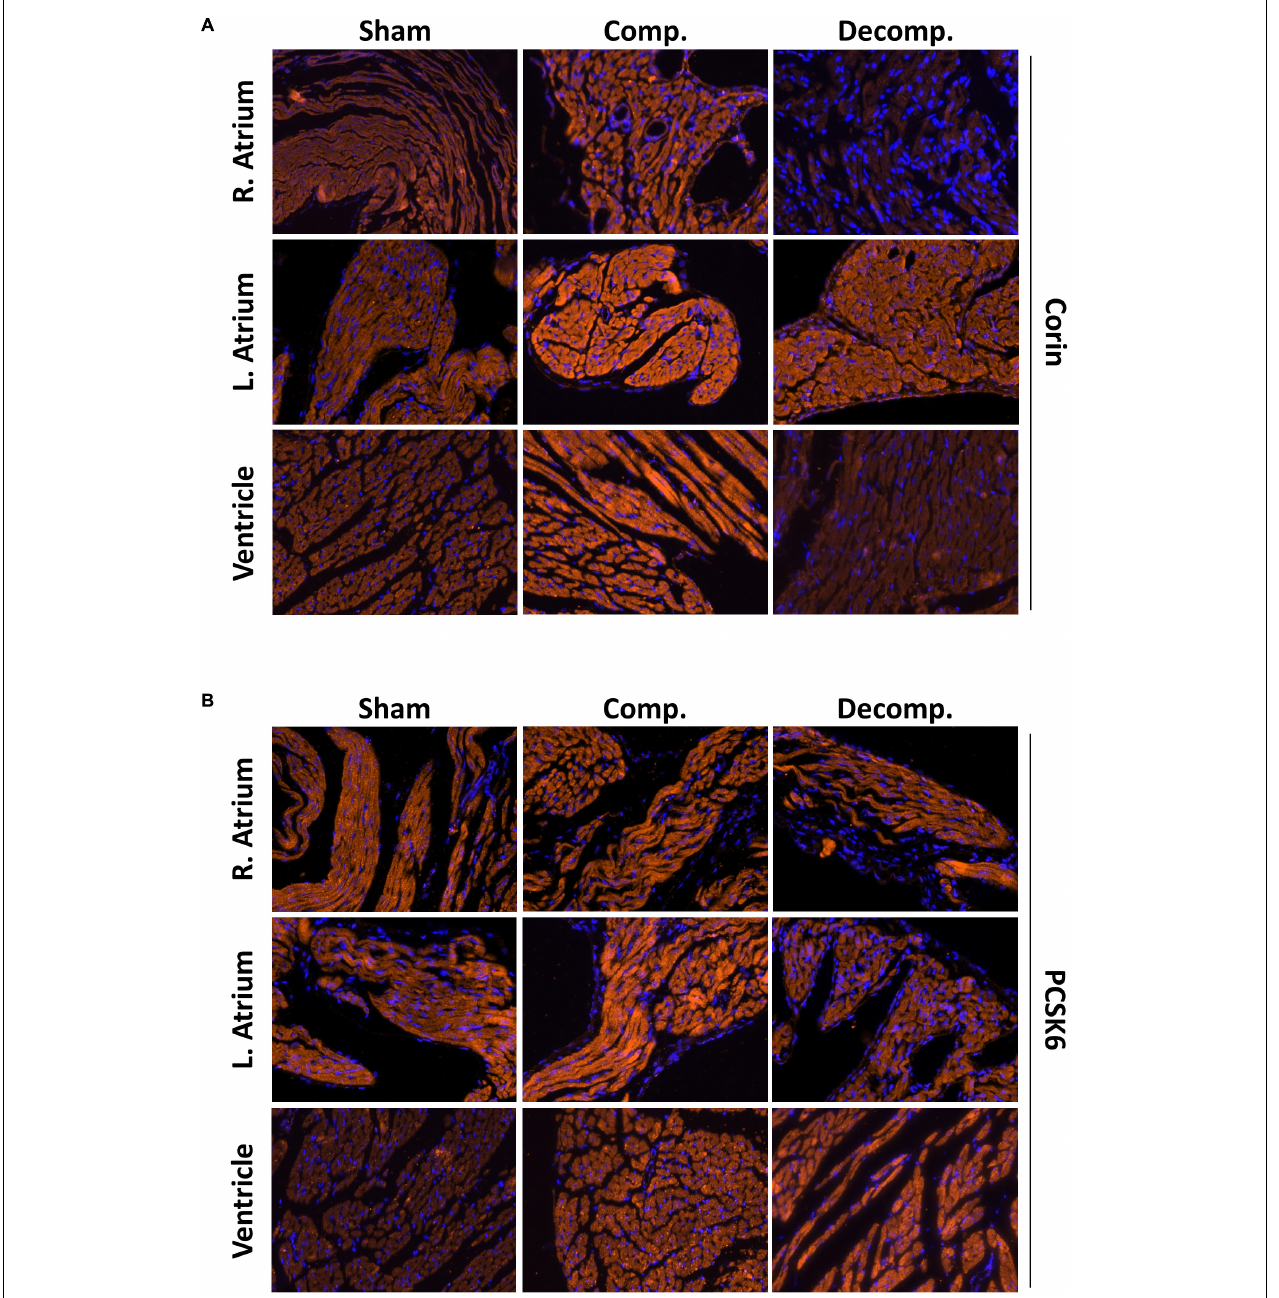
FIGURE 4 | Corin/PCSK6 staining in the heart chambers of ACF and sham-operated rats. Representative images of immunofluorescence staining for corin (A) and PCSK6 (B) in the cardiac atrial and ventricular tissues of rats with compensated CHF, decompensated CHF, and sham-operated animals. Tissues were counterstained with DAPI. All images were obtained at x40